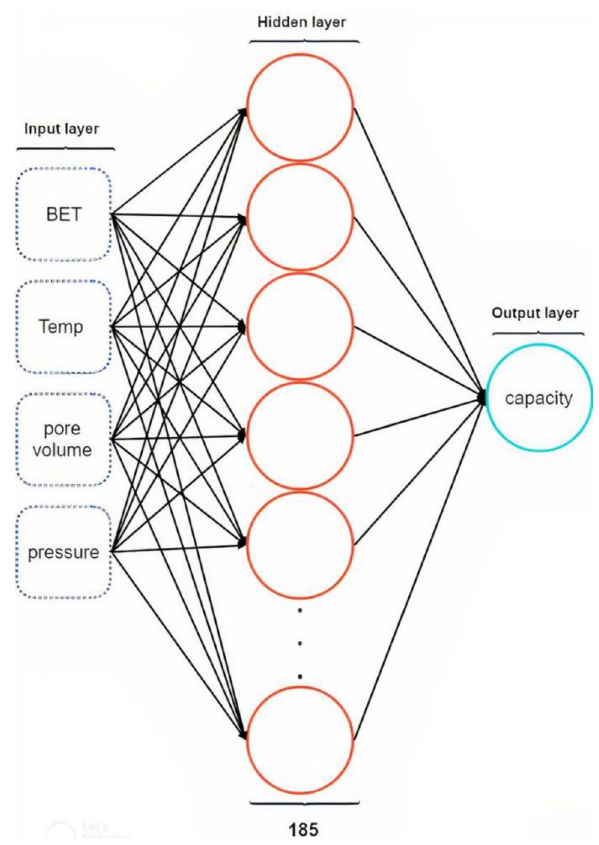
Figure 8. Schematic diagram of RBFNN model used for optimizing.